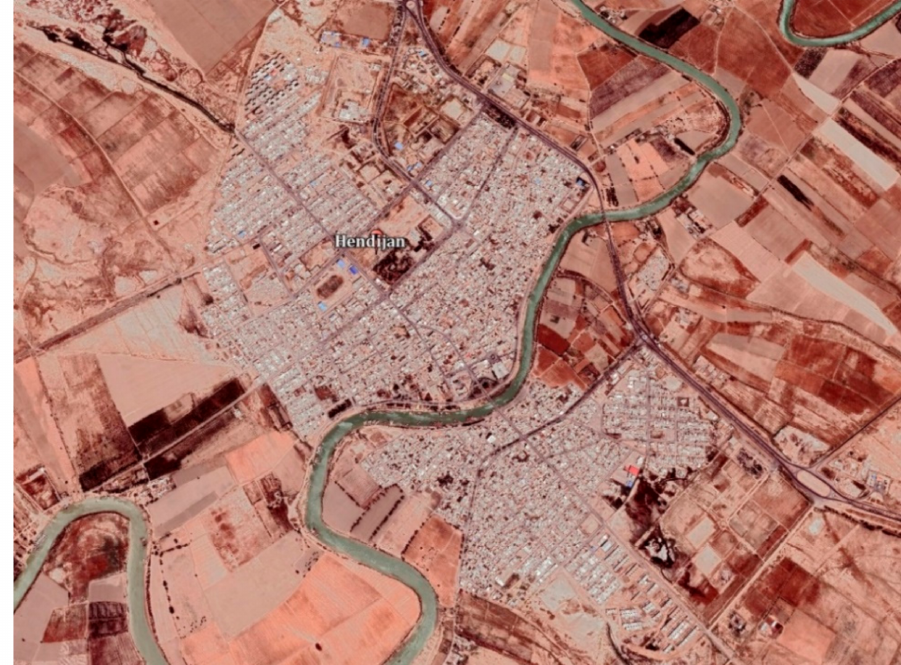
Figure 7. The case study (Google maps).